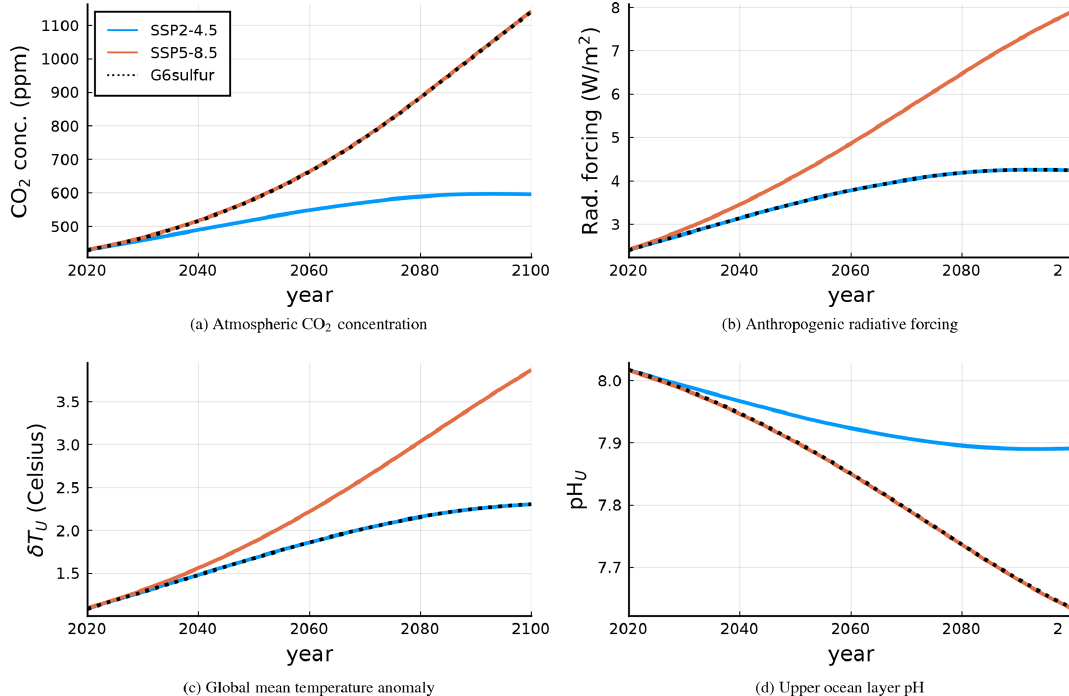
Figure 17. SURFER’s output for the G6sulfur experiment in the black dotted line. Orange and blue lines are the SSP5-8.5 and SSP2-4.5 emission scenarios for comparison.